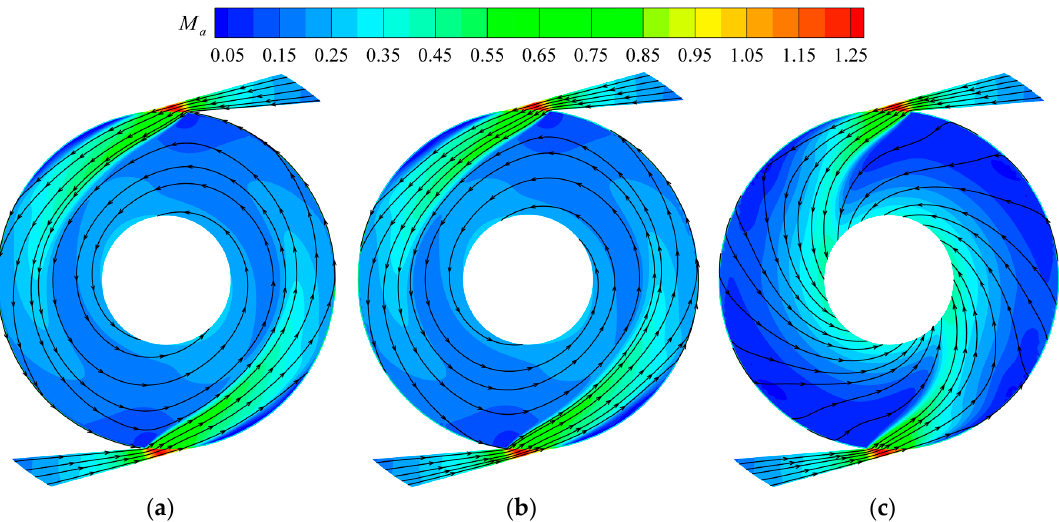
Figure 7. Mach number contours and streamlines on the mid-sections of three DCs for the one-to-one turbine Case 1-0.5 at 30,000 r/min: ( a ) DC1; ( b ) DC2; and ( c ) DC3.